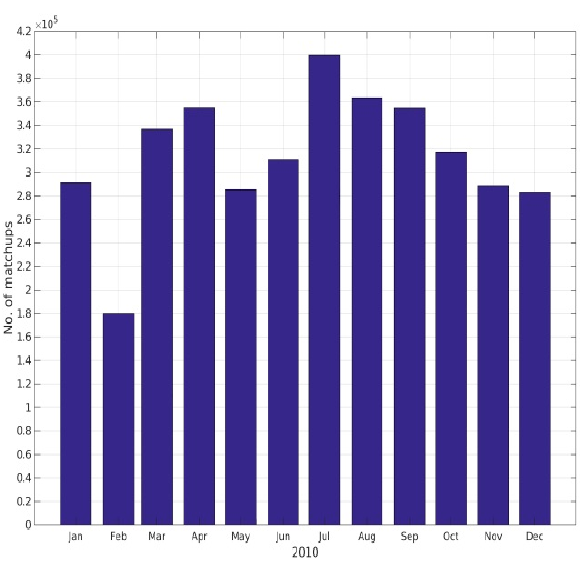
Figure 1. Number of matchups per month.